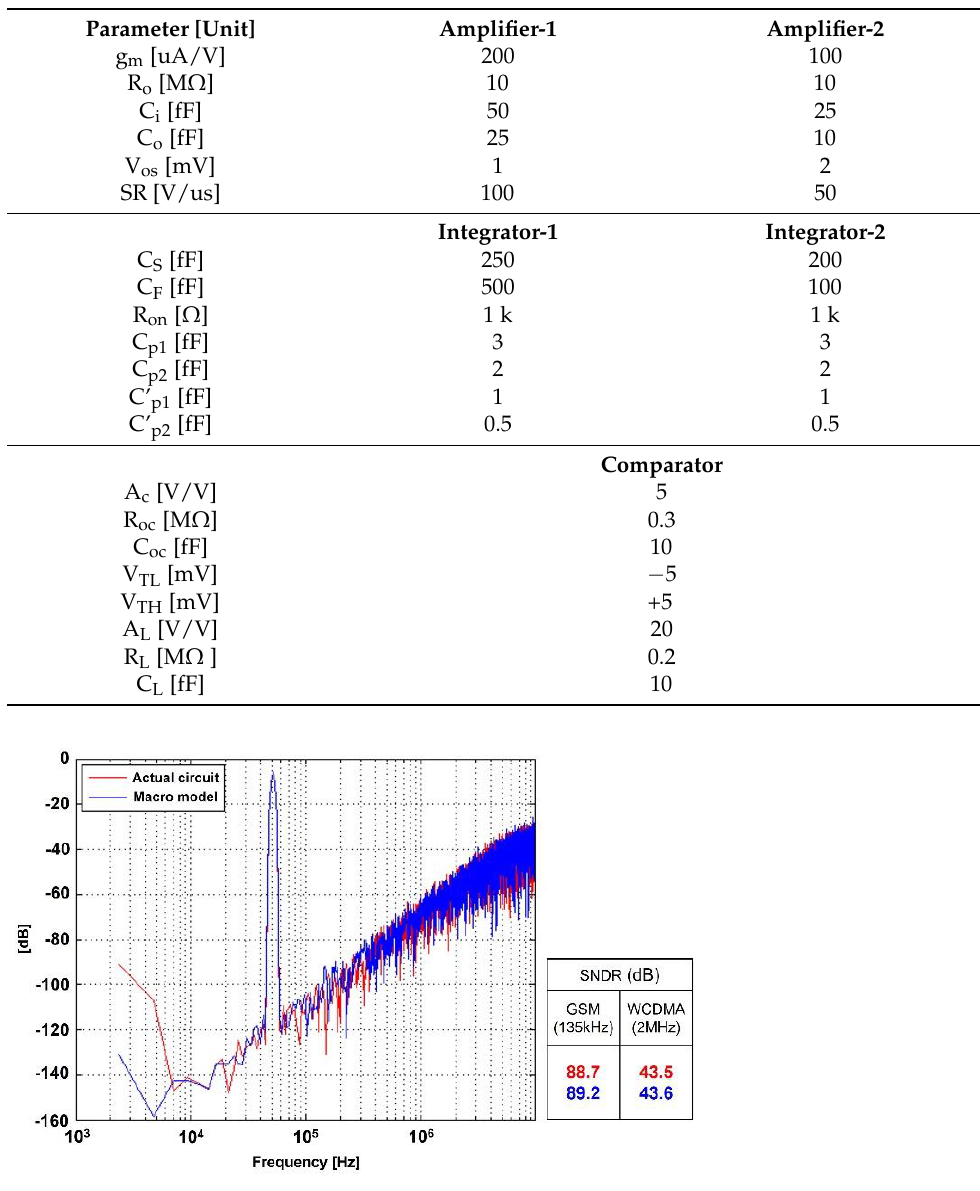
Figure 8. Transistor level and macro model sigma-delta modulator output spectrum.